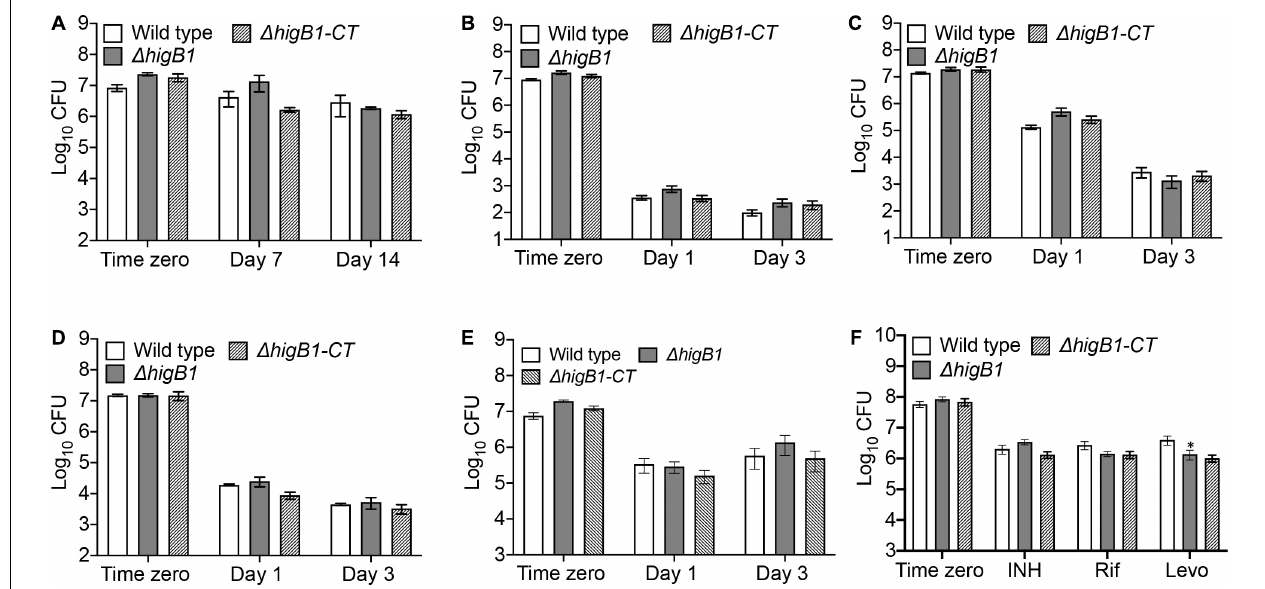
FIGURE 4 | HigB1 is dispensable for M. tuberculosis growth in different stress conditions or drugs in vitro . The survival of various strains was compared in different stress conditions such as nutritional (A) or oxidative (B) or nitrosative (C) or cell wall disrupting agents, SDS (D) , lysozyme (E) or after exposure to drugs (F) . The data shown in these panels is mean ± SE of Log 10 CFU obtained from two independent experiments performed in either duplicates or triplicates. Statistically significant differences were observed for the indicated groups, ∗ P < 0.05.